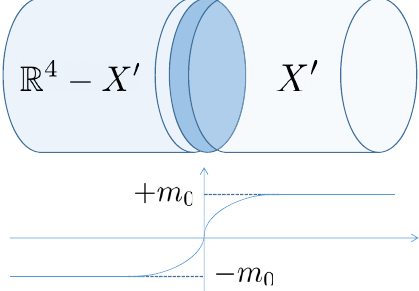
FIG. 4. The bulk-interface-bulk equivalence of the partition function (110) where the PV regulator mass is − m 0 in Eqs. (A1) and